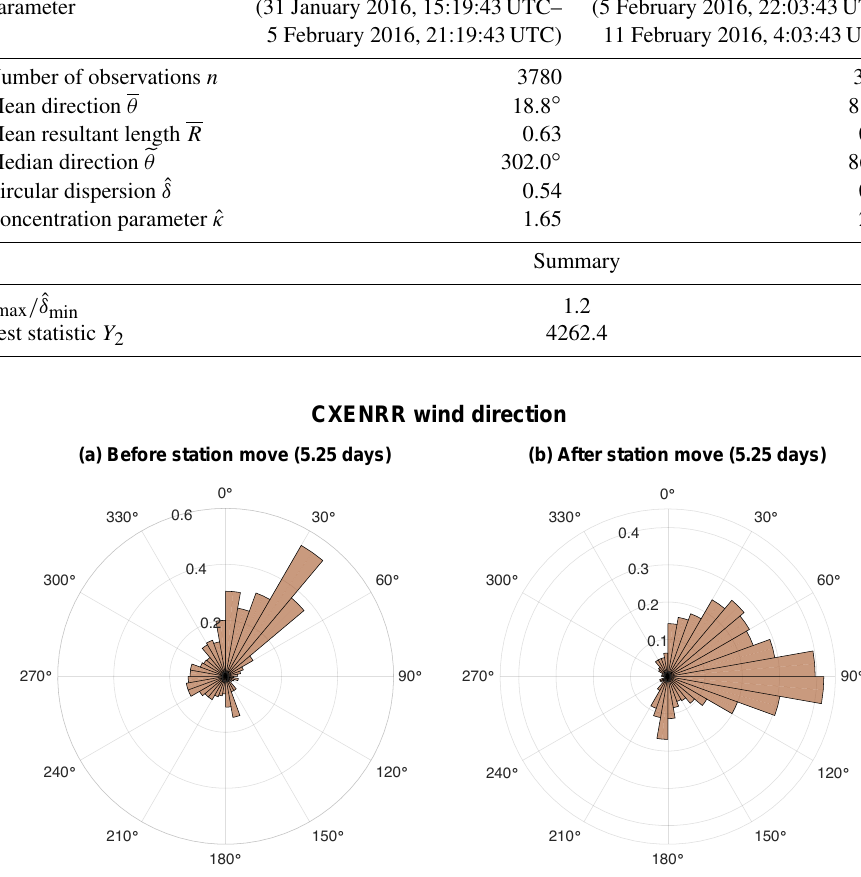
Figure 12. Rose diagrams of 5.25 days’ worth of 2min averages collected immediately before (a) and after (b) the CXENRR station was moved on 5 February 2016. Sector lengths are proportional to the square root of the relative frequency of that 10 ◦ bin, so the area of each sector is proportional to that bin’s